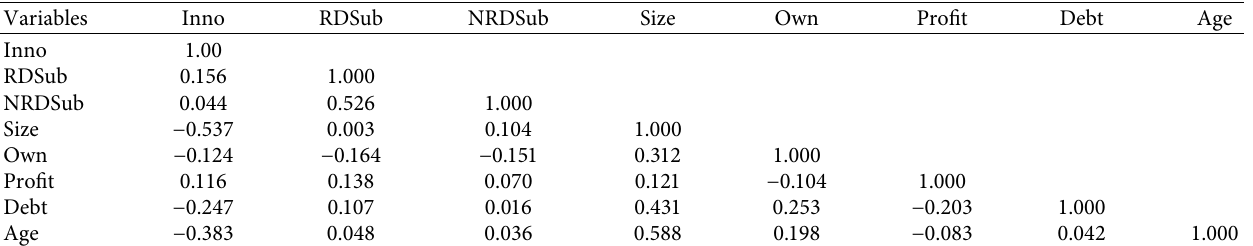
Table 3: Correlation between independent variables.